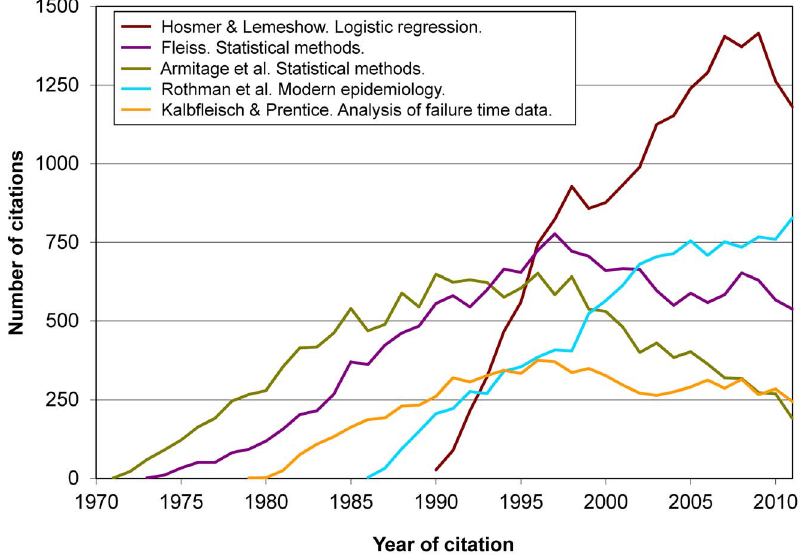
Figure 2. Evolution over time of citations received by the study 5 top-cited books (total, 73,006 citations).